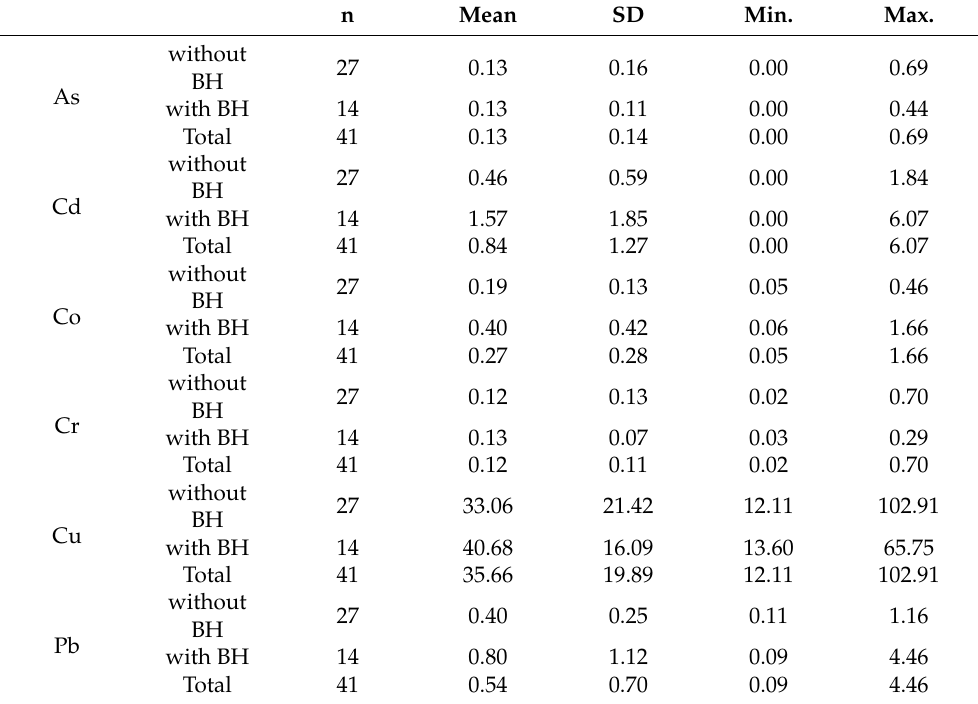
Table 1. Summary of metal(loid)s’ concentrations in liver samples (mg/kg dw).